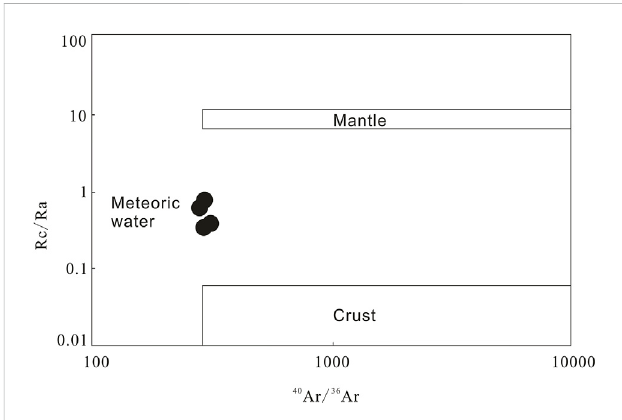
FIGURE 9 Plot of Rc/Ra – 40 Ar/ 36 Ar ratios of fl uid inclusions in pyrites from the Yangjiakuang gold